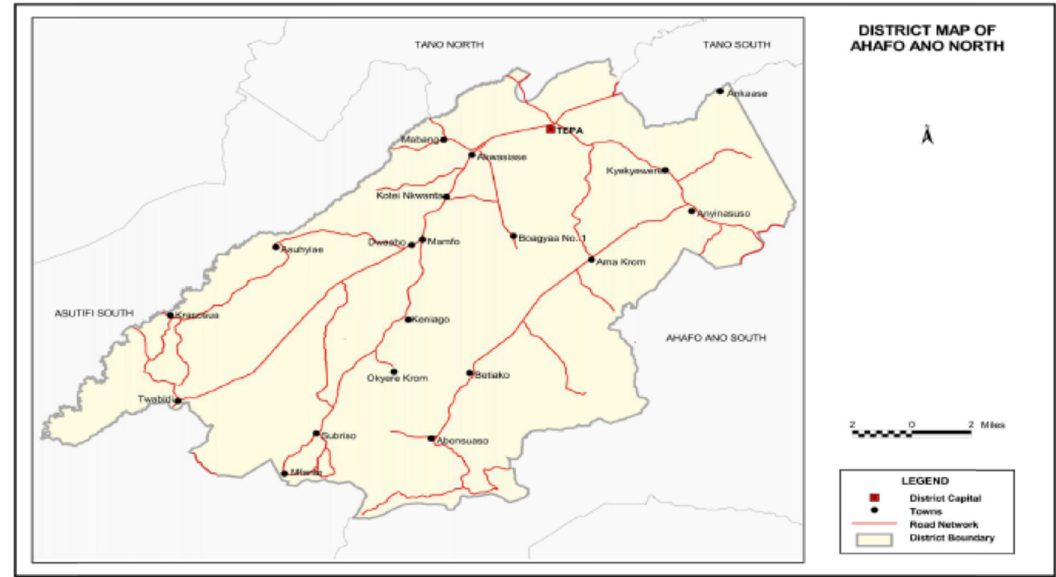
Figure 1: Map of Ahafo Ano North District ( Source: Ghana statistical service 2014 )